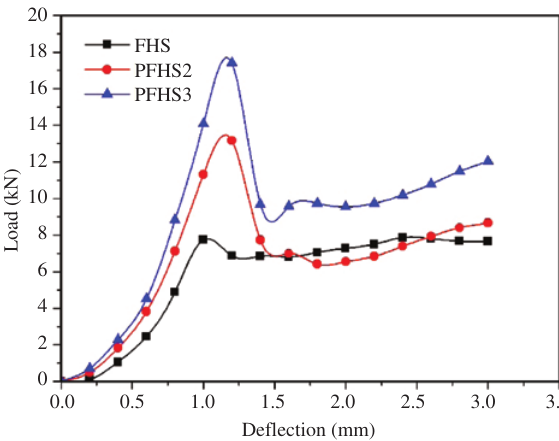
Figure 8: Load-deflection curves of the sandwich panels subjected to flatwise compression